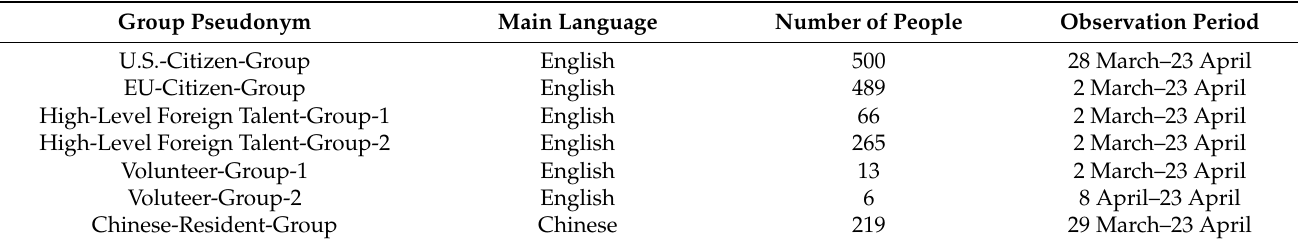
Table 1. WeChat Group